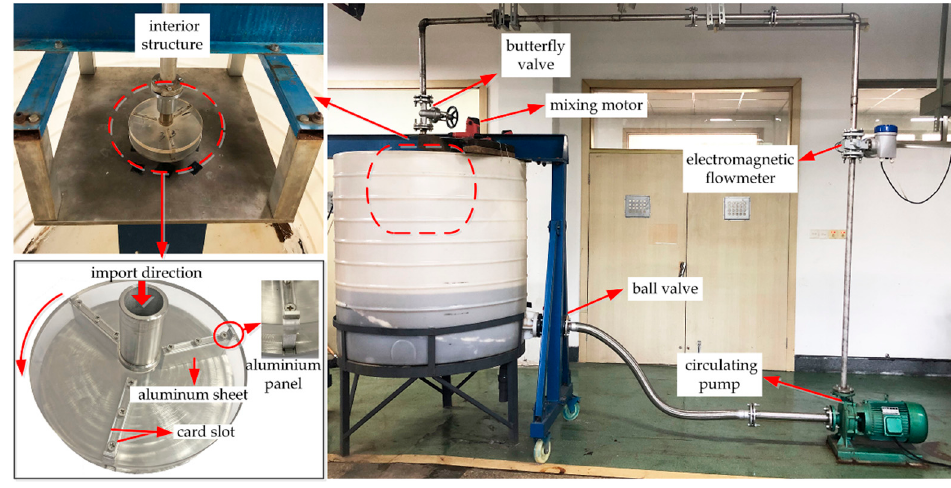
Figure 2. Photographic view of the experimental table.